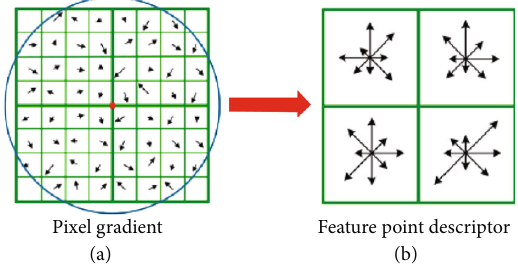
Figure 4: Feature point illustrations.